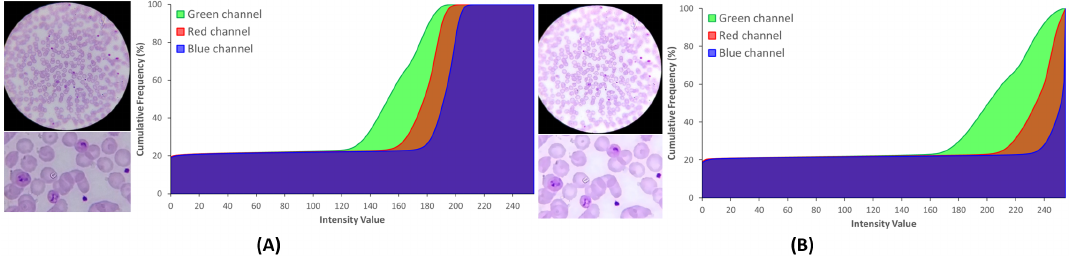
Figure 5. Effect of brightness and contrast adjustment, with cumulative histograms: ( A ) original image; ( B ) processed image after α and β correction, followed by mean-shift